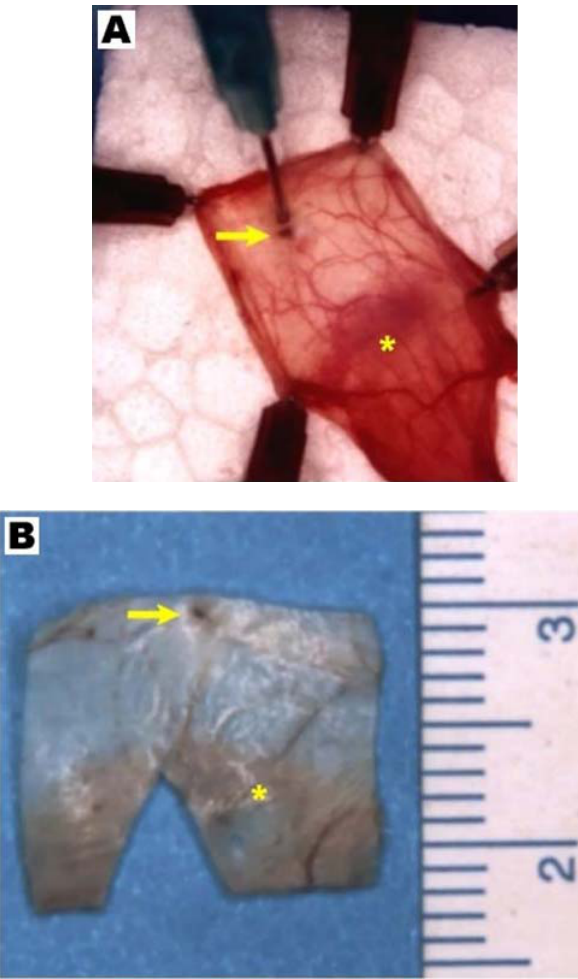
FIGURE 5 - Preparation of cheek pouch for histological exam. A) The resected pouch is distended and fixed on a styropor base, and the graft fragment site (arrow) is marked with a needle, different of the others, in a just-distal point. B) After 2 days in formaldehyde, the pouch is cut as a square, tangent the hole left by the reference needle, in contra-lateral position to the pouch retractor muscle (*). A sector is excised as a triangle on the pouch, at the opposite side of the grafted fragment, to mimic an arrow pointing to the side of the square where it is